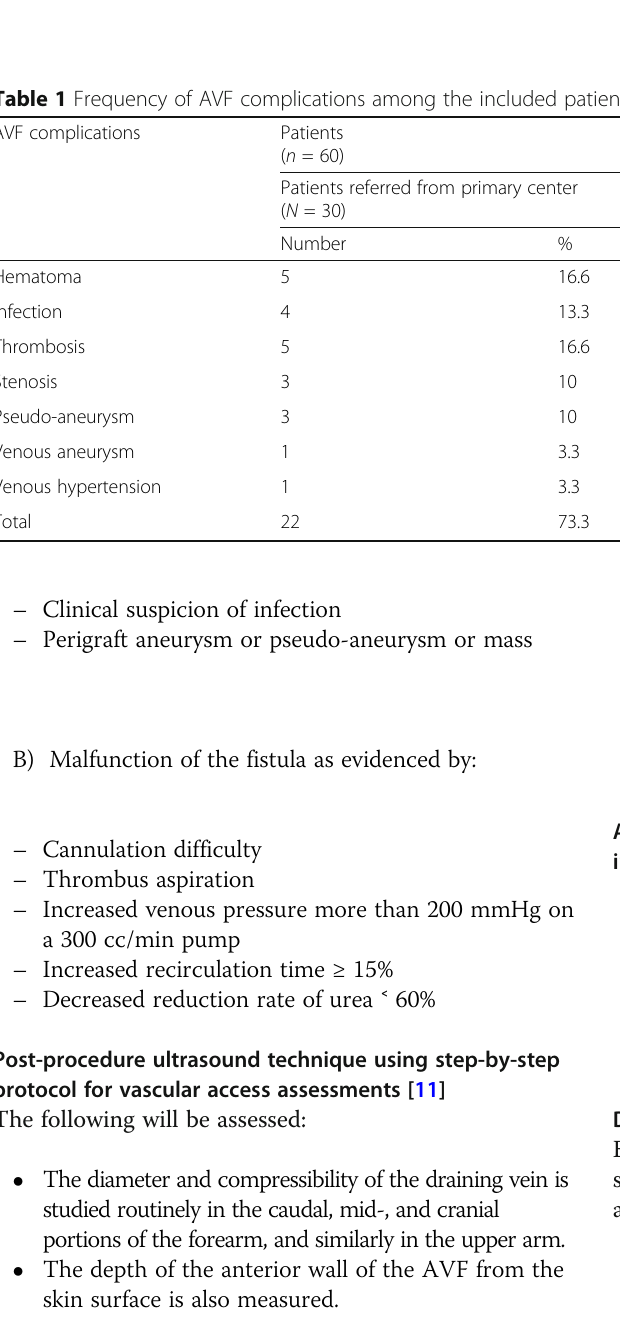
Patients referred from tertiary center ( N = 30)